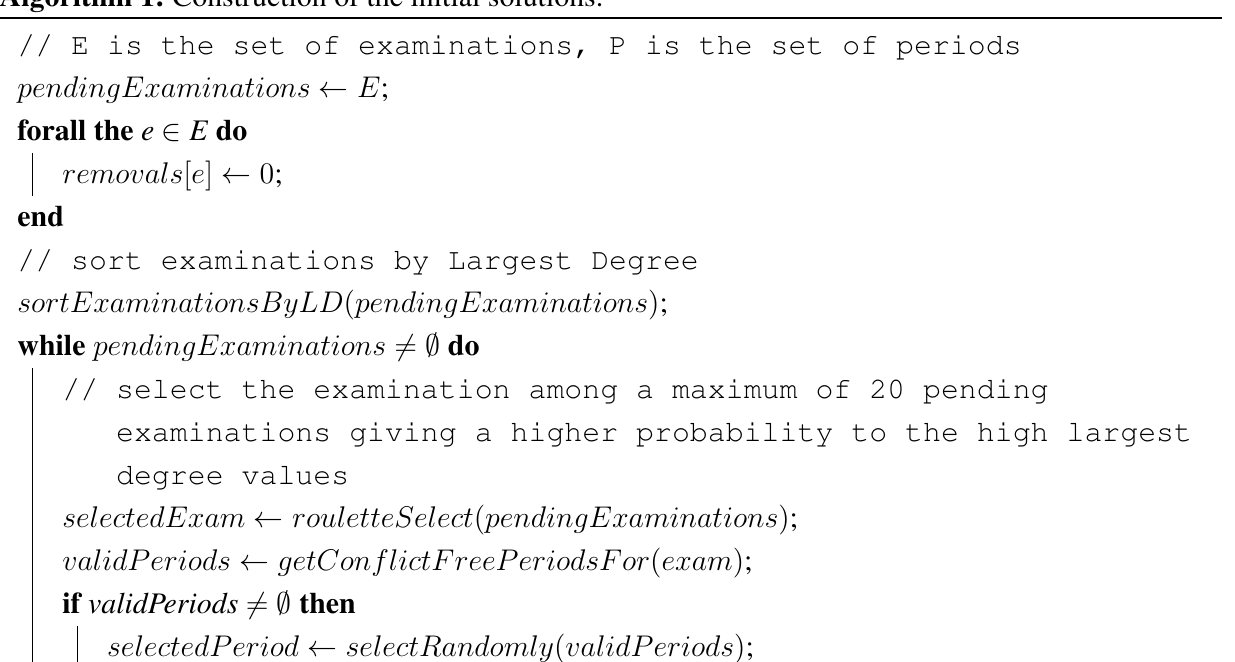
Algorithm 1: Construction of the initial